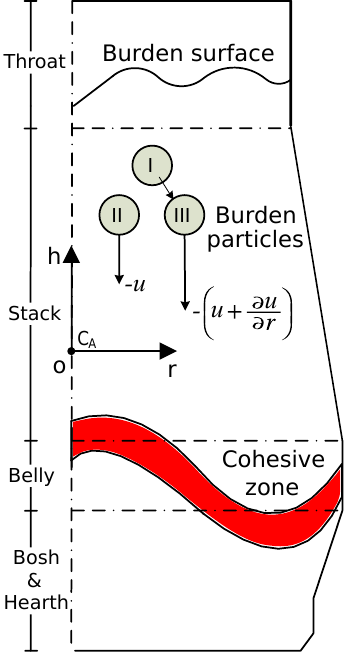
Figure 4. Kinematic modeling mechanism